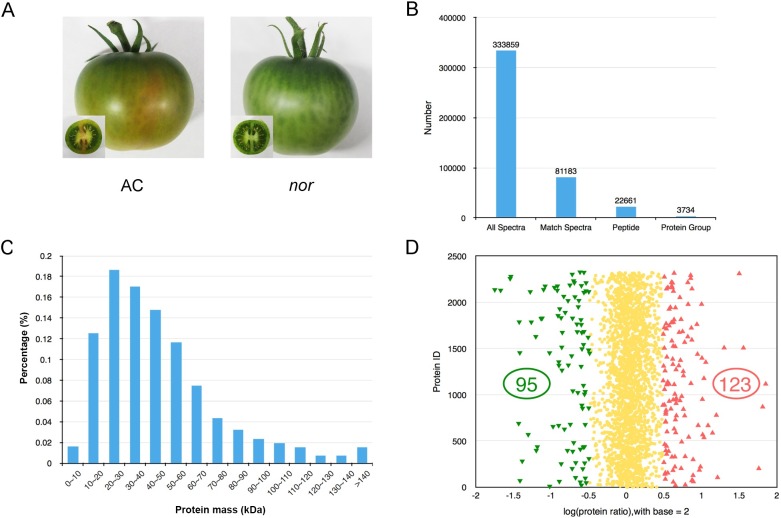
Overview of the identified proteins in the Nor mutant fruit.(A) Phenotype of AC and Nor tomato fruit at 44 DPA for the iTRAQ study. (B) The number of all spectra, match spectra, peptides, and protein groups from the iTRAQ analysis. (C) Identified proteins were grouped according to their protein mass. (D) Abundance distribution of the identified proteins in Nor mutant versus AC fruit across three biological replicates. Green triangles indicate significantly decreased proteins (n = 95), red triangles represent accumulated proteins (n = 123), and yellow spots represent the non-significant proteins.